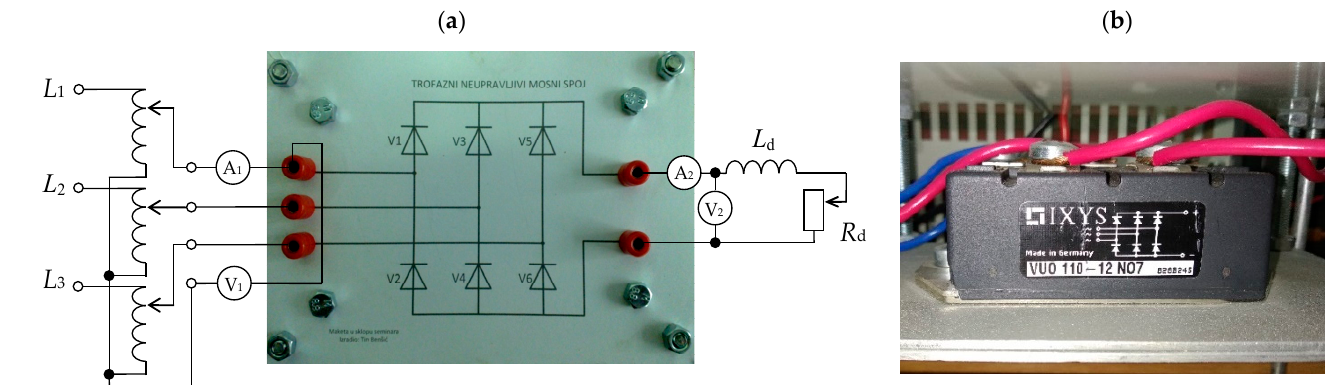
Figure 10. Top side of the assembled three-phase uncontrolled rectifier model with source and load schematic added ( a ) and industrial block rectifier IXYS VUO 110-12 NO7 used in the assembled model ( b